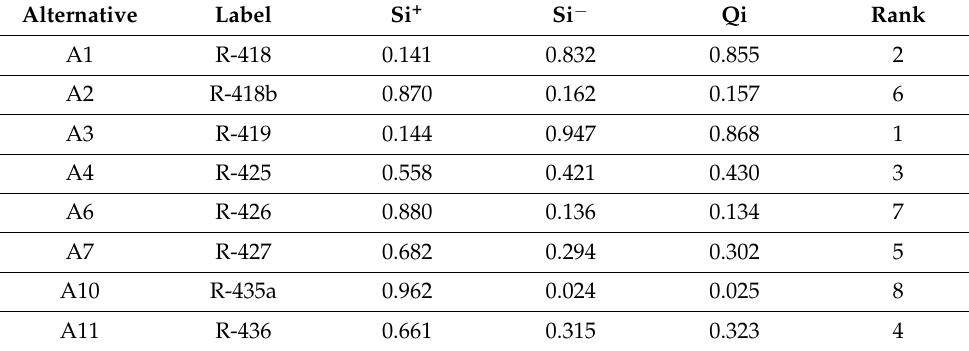
Table 9. Priority ranking of nonurban roads—Iteration